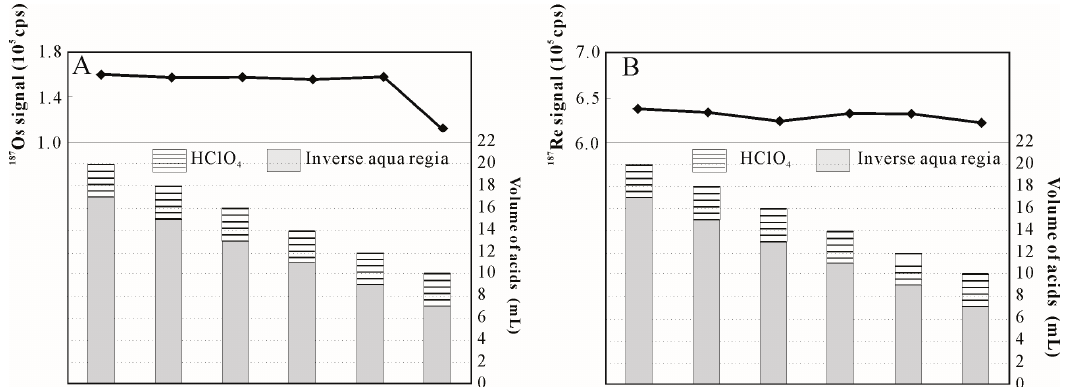
Figure 2. Os ( A ) and Re ( B ) signal for 3 g of pyrite with different volumes of digestion medium obtained using the HClO4-inverse aqua regia method.